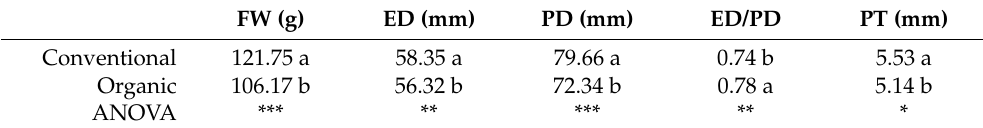
Table 2. Physical parameters of lemon “Fino 49” cultivated under organic and conventional farming. FW (g) ED (mm) PD (mm) ED/PD PT (mm) Conventional 121.75 a 58.35 a 79.66 a 0.74 b 5.53 a Organic 106.17 b 56.32 b 72.34 b 0.78 a 5.14 b ANOVA *** ** *** ** *